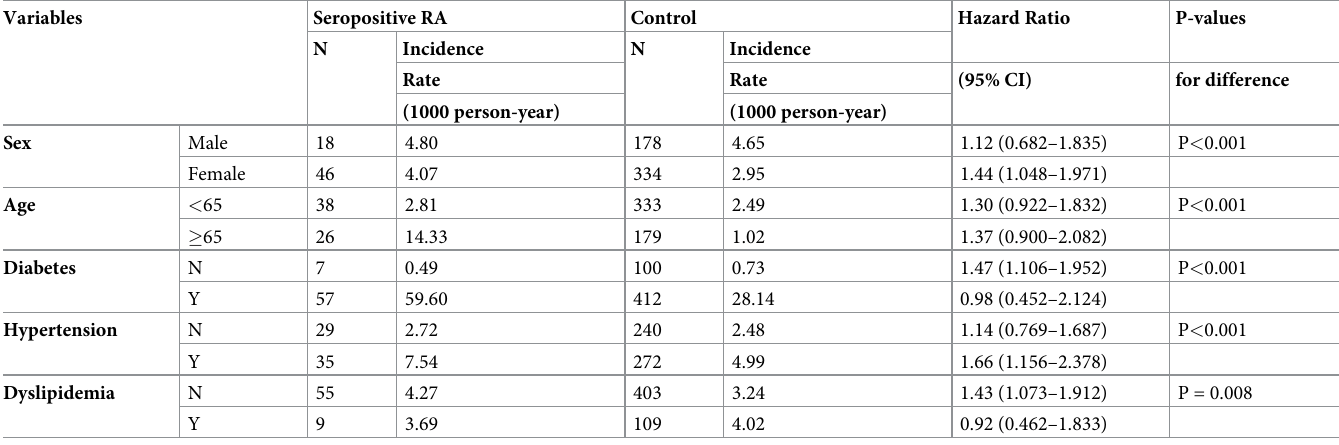
Table 3. Subgroup analyses between the seropositive RA and control groups.